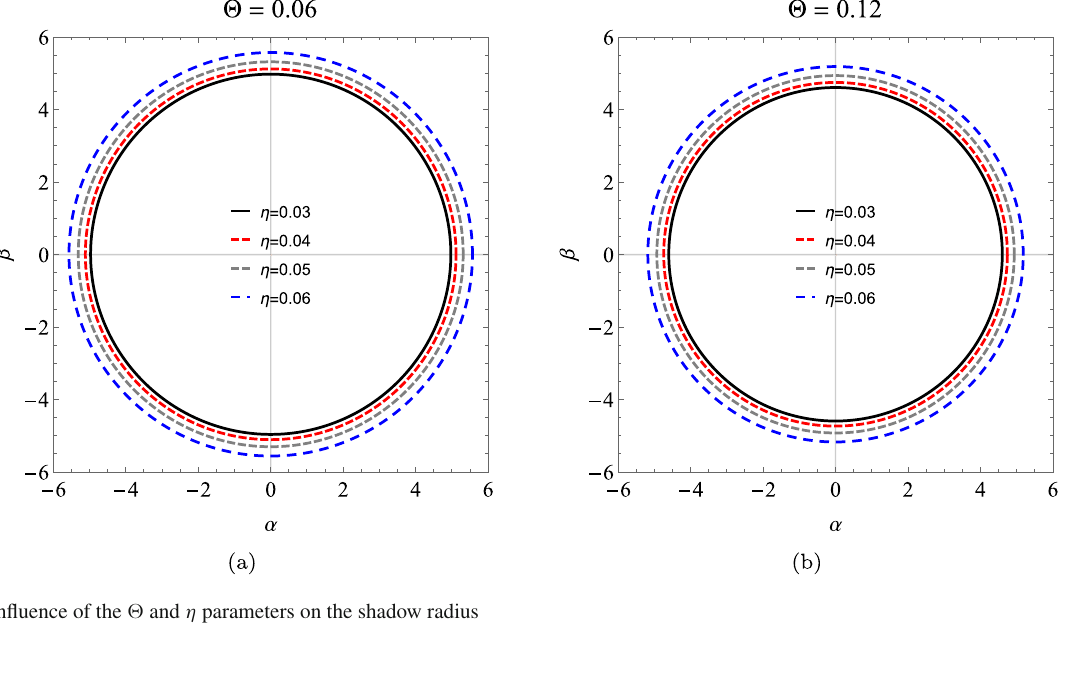
Fig. 9 Null geodesics in polar coordinates for different values of (cid:11) and η , assuming values for the impact parameter between 4 and 7. The radius of the horizon corresponds to the radius of the disk in black, the